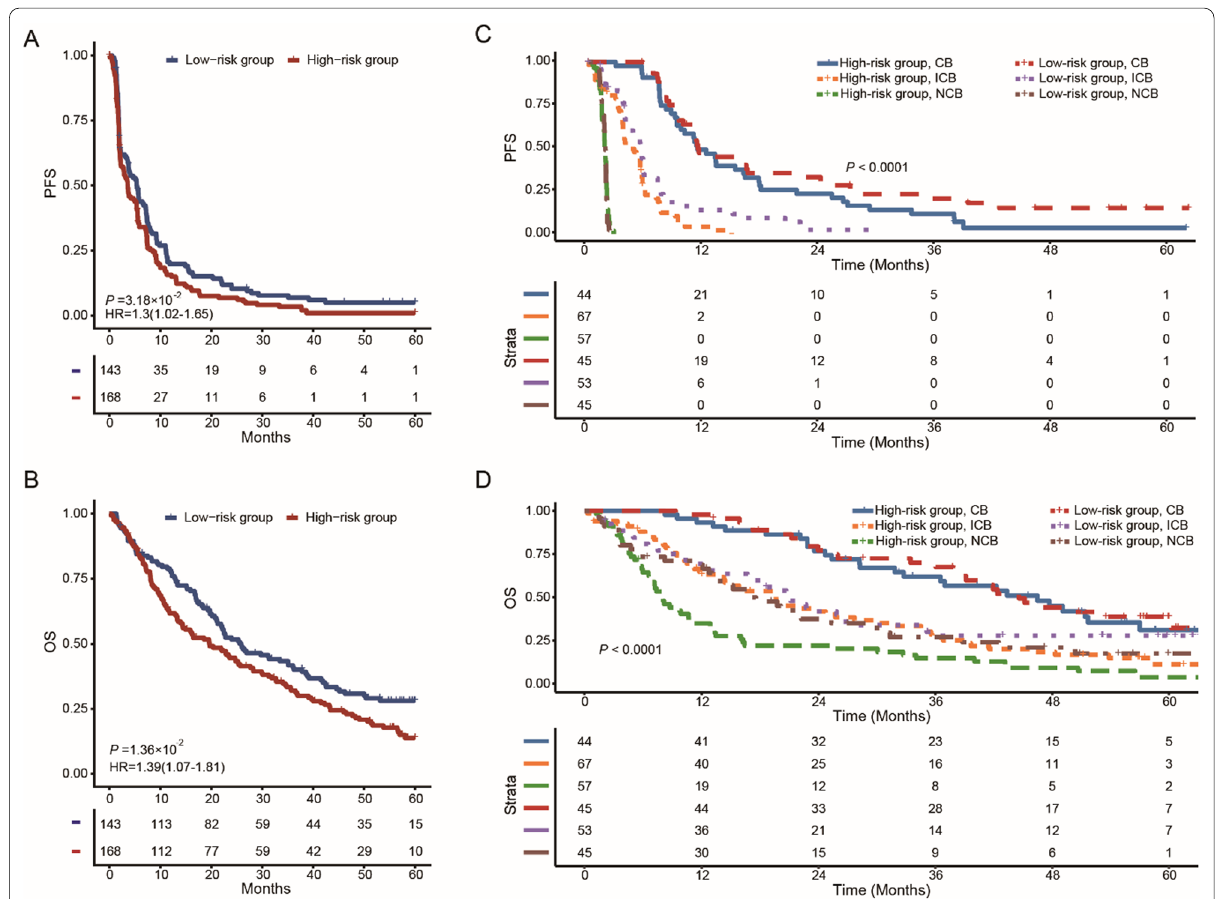
Fig. 5 Kaplan–Meier plots for validations of FRGS in a cohort of ccRCC patients who received immunotherapy. A , B The outcome of patients with different CAF risk group in ccRCC patients with immunotherapy: PFS ( A ) and OS ( B ). C , D The outcome of patients with different drug response in ccRCC patients with different CAF risk group: PFS ( A ) and OS ( B